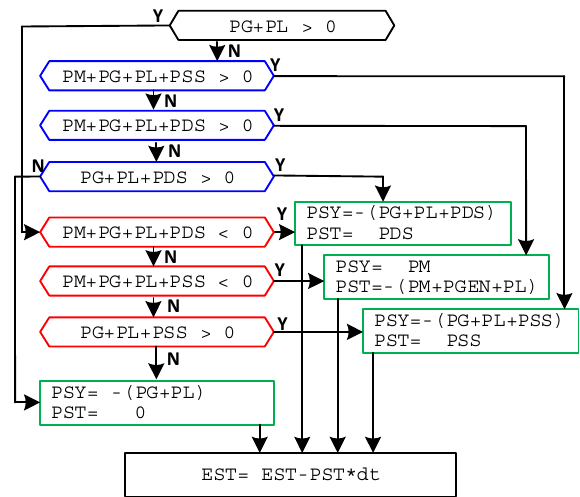
Figure 13. Storage control algorithm, PG—power generation (positive), PL—load (negative), PSS—storage charging power (negative), PDS—storage discharging power (positive), EST—storage energy, PM—set level of power exchange between the private network and the distribution system.